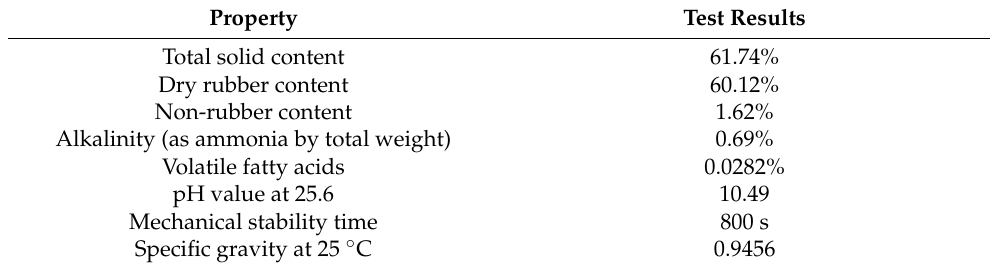
Table 1. Chemical analysis of the NL.